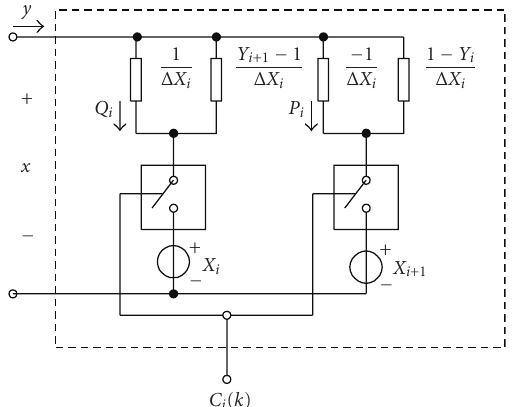
Figure 3: Equivalent circuit for a PWL segment.